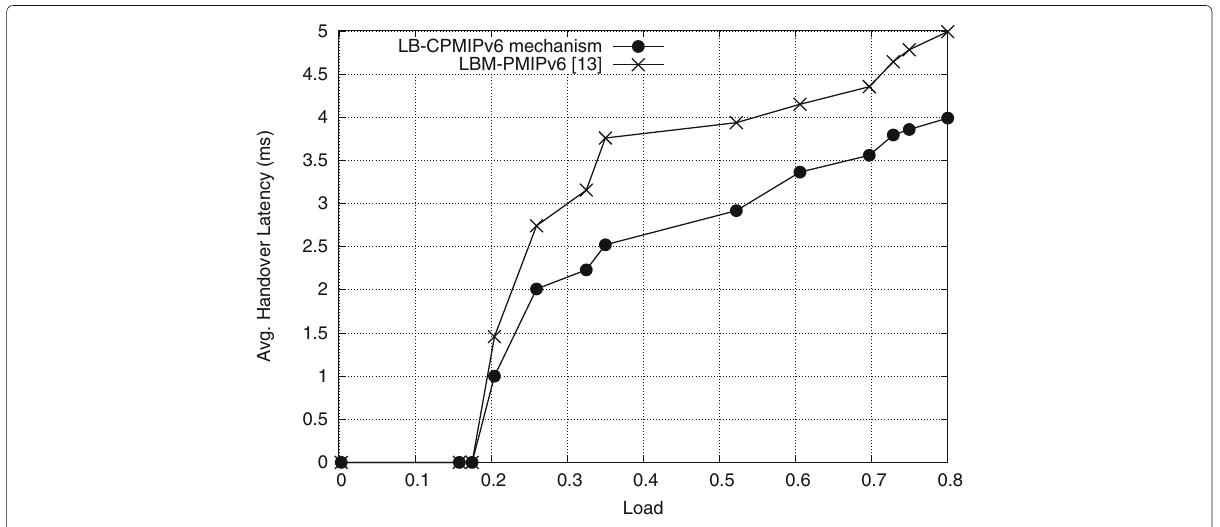
Fig. 15 Impact of intra-cluster handoff on the handover latency